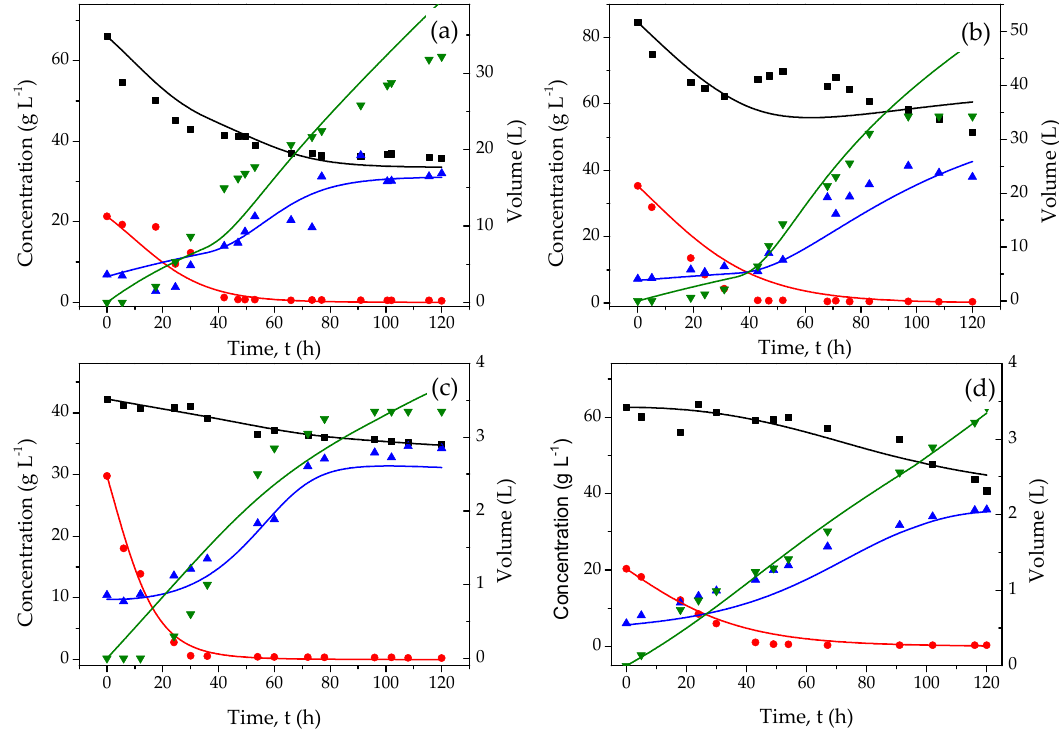
Figure 3. Dynamical behavior of key parameters at different operation conditions ( ■ COD exp , ● S 1,exp, ▲ VFA exp , ▼ Biogas, (cid:31) COD fit , (cid:31) S 1fit , (cid:31) VFA fit , (cid:31) Biogas fit ) ( a ) pH = 5.5, T = 35 °C; ( b ) pH = 5.5, T = 40 °C; ( c ) pH = 7.5, T = 35 °C ; and ( d ) pH = 7.5, T = 40 °C.